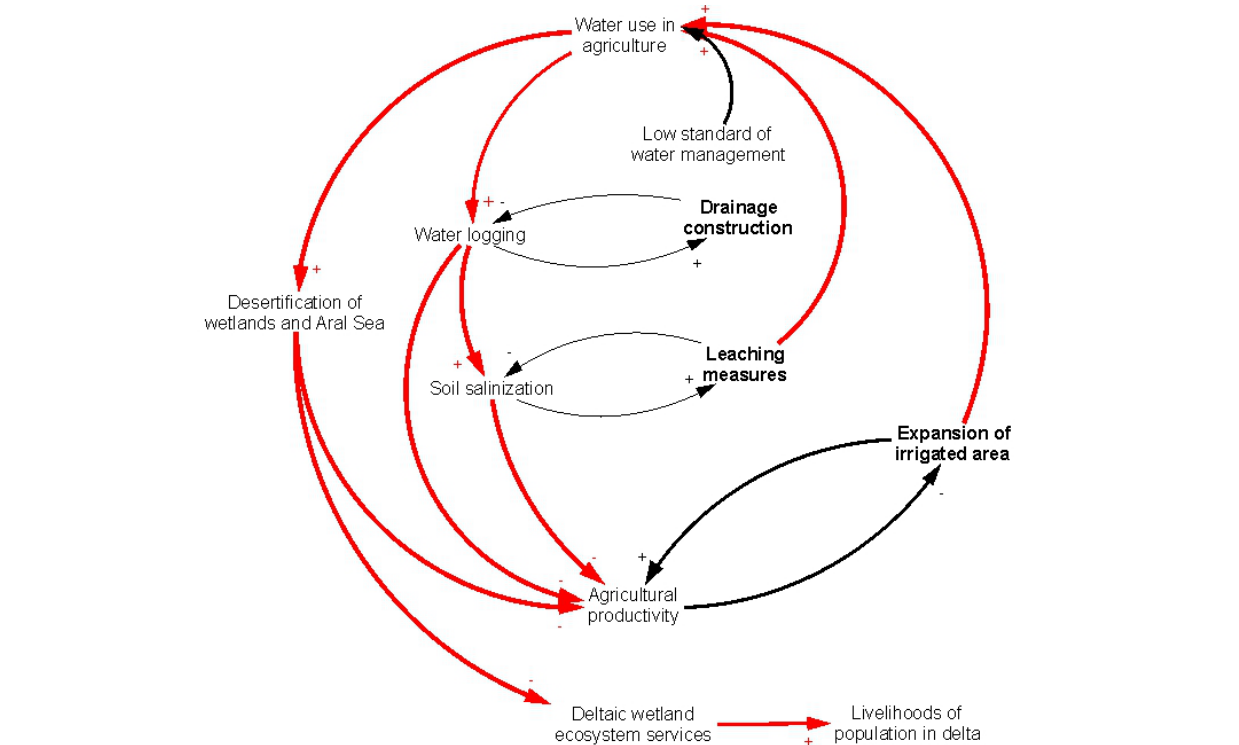
Fig. 2 . Major interactions and feedbacks between the ecological and social